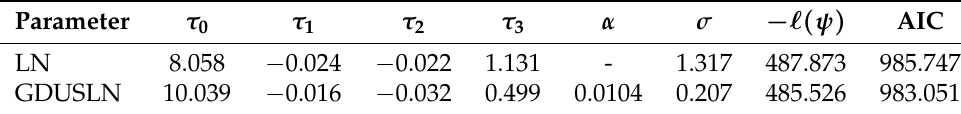
Table 16. Regression results on Stanford heart transplant dataset.